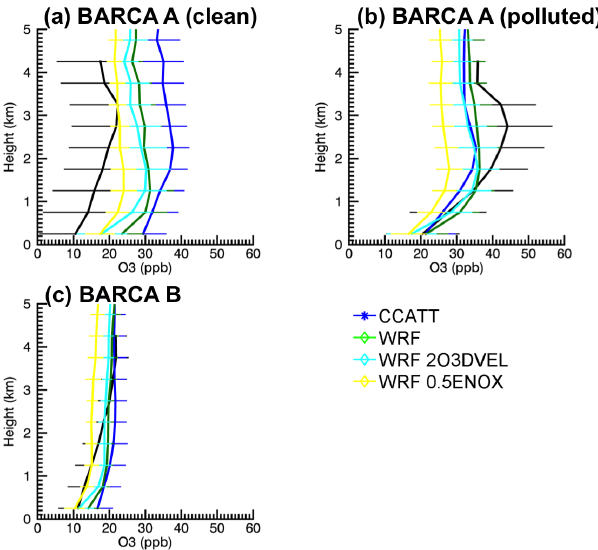
Figure 16. O 3 as observed (black circles) and simulated with CCATT-BRAMS (blue stars) and WRF-Chem (base case: green di- amonds, 2DEPVEL: cyan circles, and 0.5ENOx: yellow squares) during (a) BARCA A, clean conditions (west, north, and around Manaus regions), (b) BARCA A, polluted conditions (east and south regions), and (c) BARCA